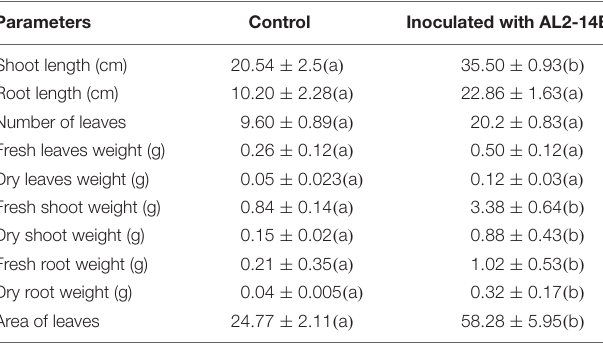
TABLE 2 | Effect of P. aeruginosa AL2-14B on the growth characteristics of the A. aspera L. Parameters Control Inoculated with